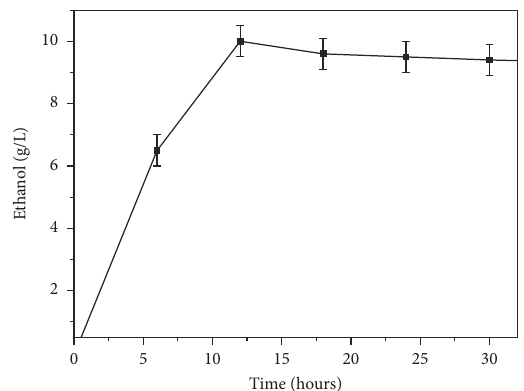
Figure 7: The effect of time on ethanol